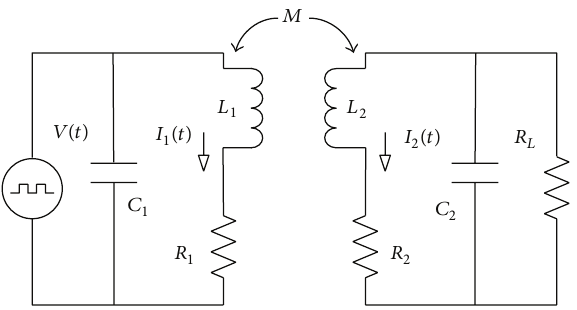
Figure 3: Power transmission link